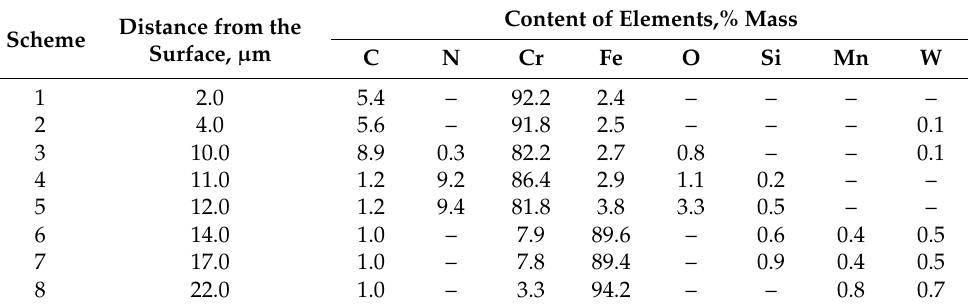
Table 4. Distribution of chemical elements for steel DIN 105WCr6 after nitrogenchroming: